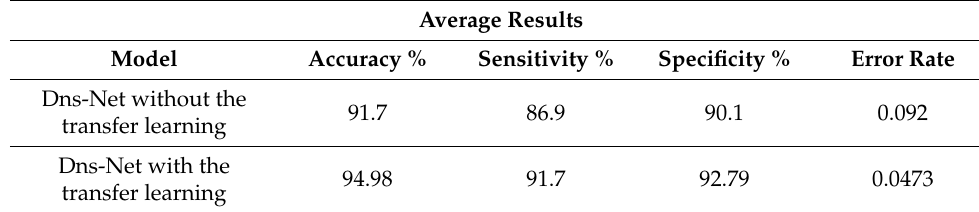
Table 3. Experimental Results.